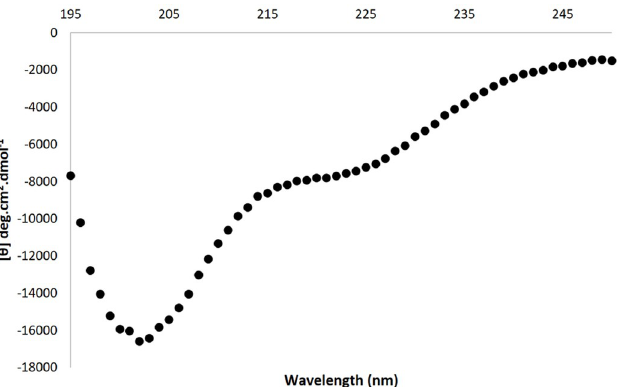
Fig 5. Far-UV CD spectrum of the RBBP6-p53BD. Far UV CD spectra of the RBBP6-p53BD, showing 250 nm to 195 nm for 2.6 μ M RBBP6-p53BD in 20 mM sodium phosphate, pH 7.